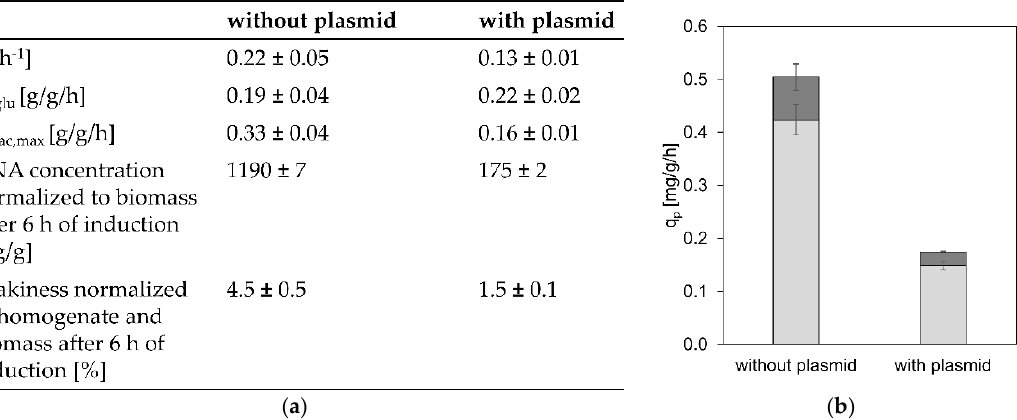
Figure 3. Physiology, leakiness, lysis and productivity for the GI-strain with and without an additional pET plasmid. ( a ) Comparison of physiological data as well as leakiness and lysis of a cultivation of the GI strain without plasmid and the GI strain containing the empty pET-21 d (+) plasmid; ( b ) Specific overall, intracellular (light grey), and extracellular (dark grey) product formation rates compared between the cultivations with and without plasmid.